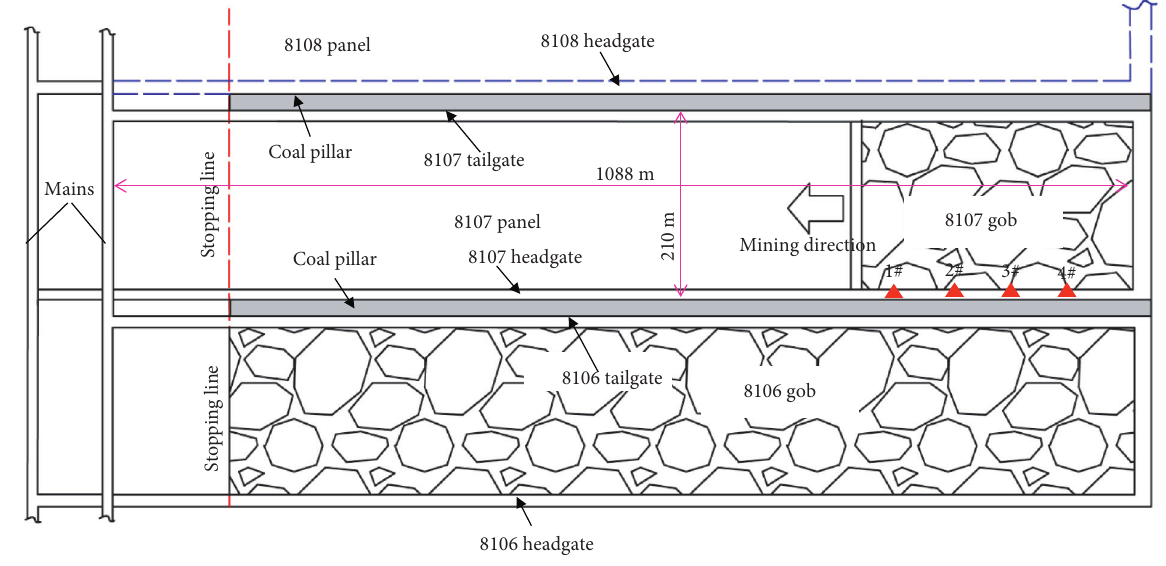
Figure 2: Panels and roadway layout.